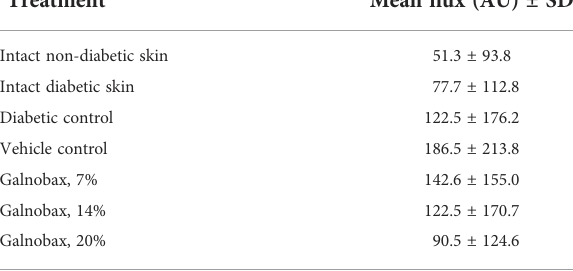
TABLE 3 Average fl ux of blood fl ow on the epithelialized skin in various groups. Treatment